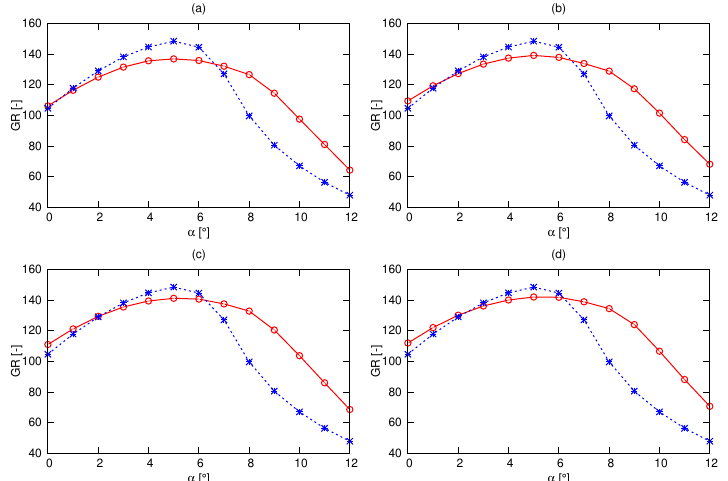
Figure 15. GR of the reference and optimized hydrofoils of the first case of 2D optimization, where ( a ) is GR of HF-2D-1-1, ( b ) is GR of HF-2D-1-2, ( c ) is GR of HF-2D-1-3 and ( d ) is GR of HF-2D-1-4. The red and blue lines denote optimized and reference hydrofoils,